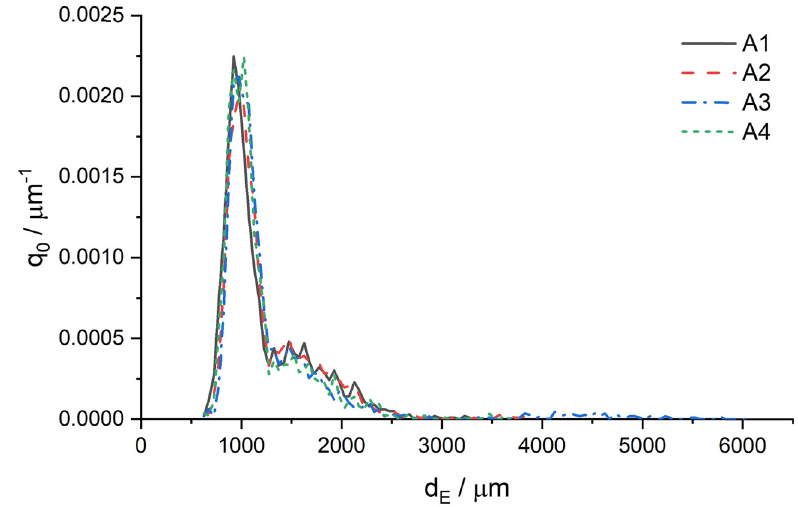
Figure 17: Particle size distributions of the sample cups ( A1 – A4 ) for a representative